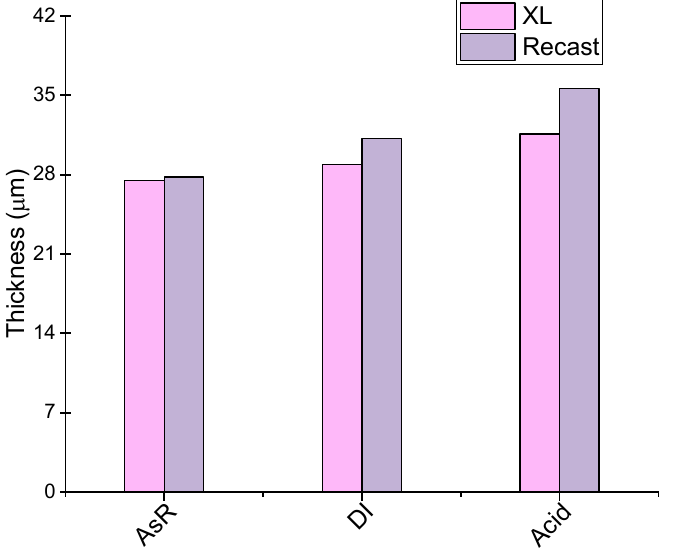
Figure 1. Influence of the different pre-treatments on the thickness of the re-cast and XL mem- brane.